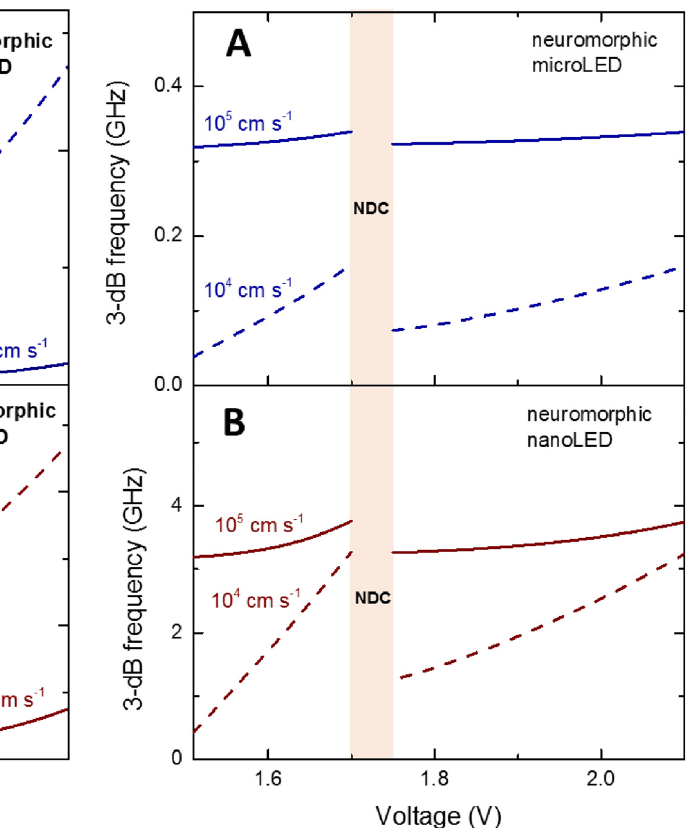
Figure 4: Simulated 3-dB bandwidth versus voltage for the neuromorphic A microLED, and B nanoLED devices. In all curves, the solid lines correspond to a surface recombination of 10 5 cm s − 1 and thedashedlinesto10 4 cms − 1 .Theverticalshadowregionrepresents the NDC corresponding to the voltage region where the DC current